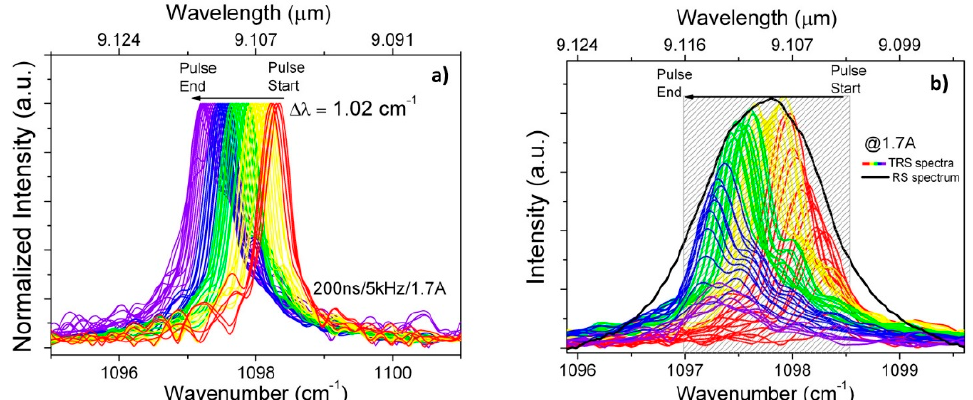
Figure 10. Normalized ( a ) and non-normalized ( b ) emission spectra extracted from the time resolved map registered for CC-QCL operated with 200 ns pulses at 5 kHz repetition rate. The black line presents the spectrum recorded in rapid scan mode of FTIR at the same experimental conditions.